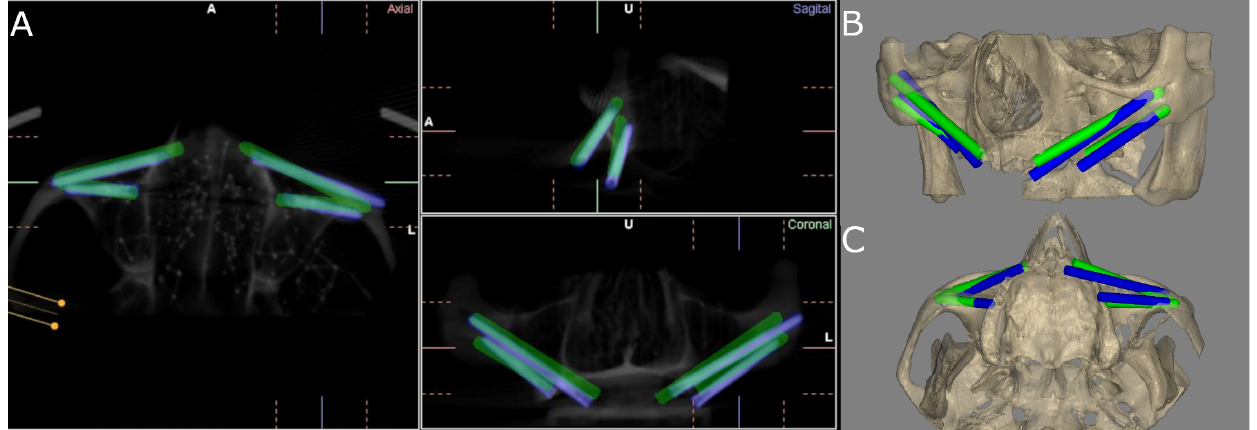
Figure 4. ( A ) CBCT images of the coronal, sagittal, and axial views; and ( B ) front and ( C ) bottom views of the three-dimensional reconstruction of the measurement procedure contrasted against the preoperative planning (green cylinders) and postoperative ZI placement (blue cylinders) of the ZIs placed on the experimental model.